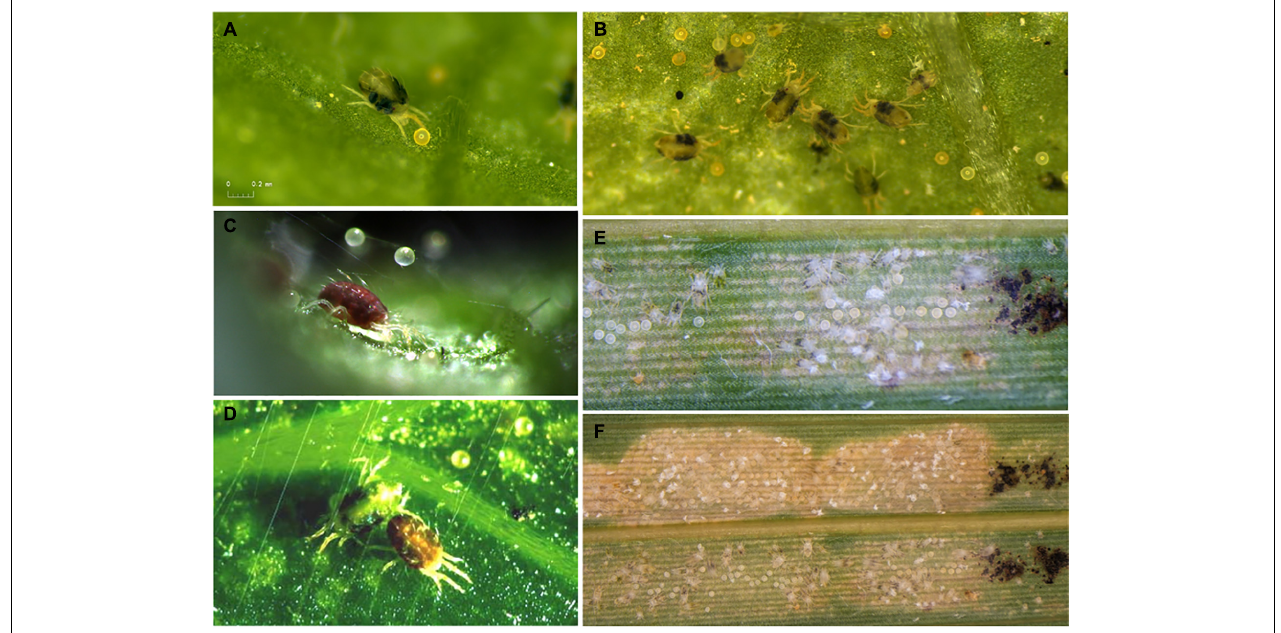
FIGURE 1 | (A) Tetranychus urticae female with egg, (B) group of T. urticae females and their offspring, (C) Tetranychus kanzawai female beneath spinning threads and eggs attached to threads, (D) T. urticae and T. kanzawai females sharing web, (E,F) nests of Stigmaeopsis longus on bamboo leaves, with all life stages and exuviae inside the nest and fecal piles outside the nest close to the entrance; the haze in (E,F) is caused by the woven roof of the nests; © (A,B) by PS, (C,D) by SY, and (E,F) by